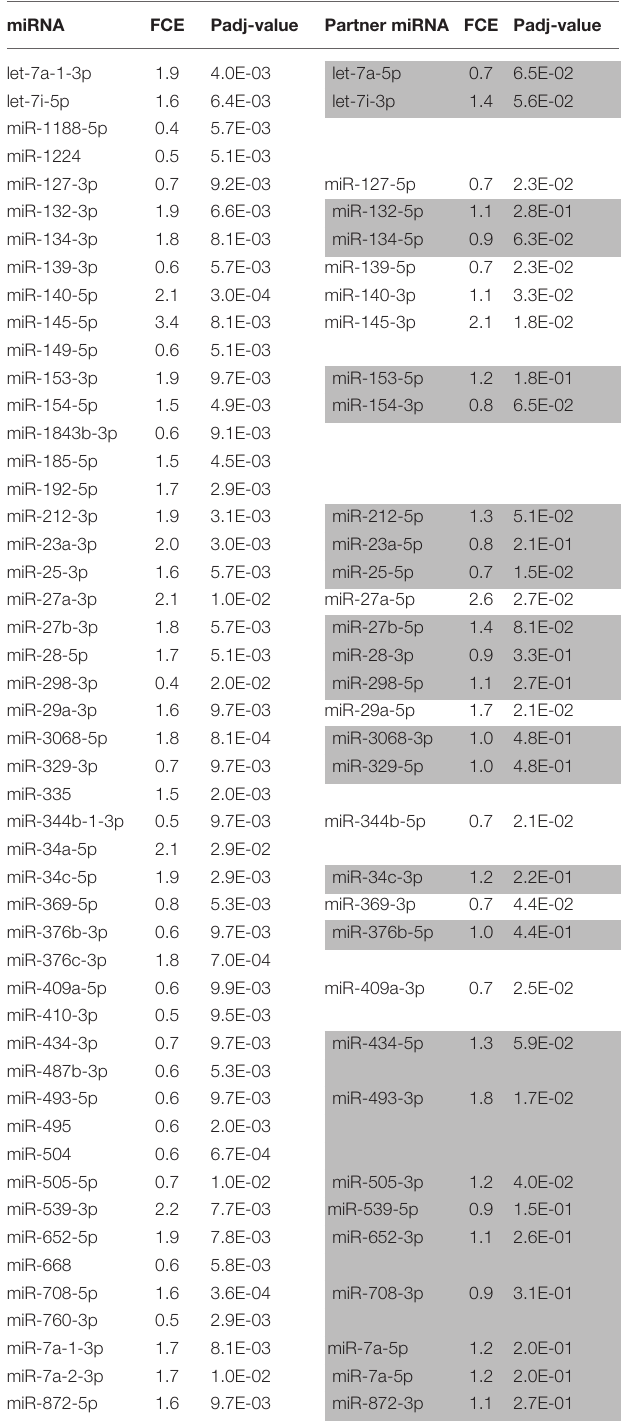
TABLE 5 | miRNA and partner-miRNA expression in groups HF-HF vs. C-C. miRNAs Differentially Expressed Between Groups C-C and